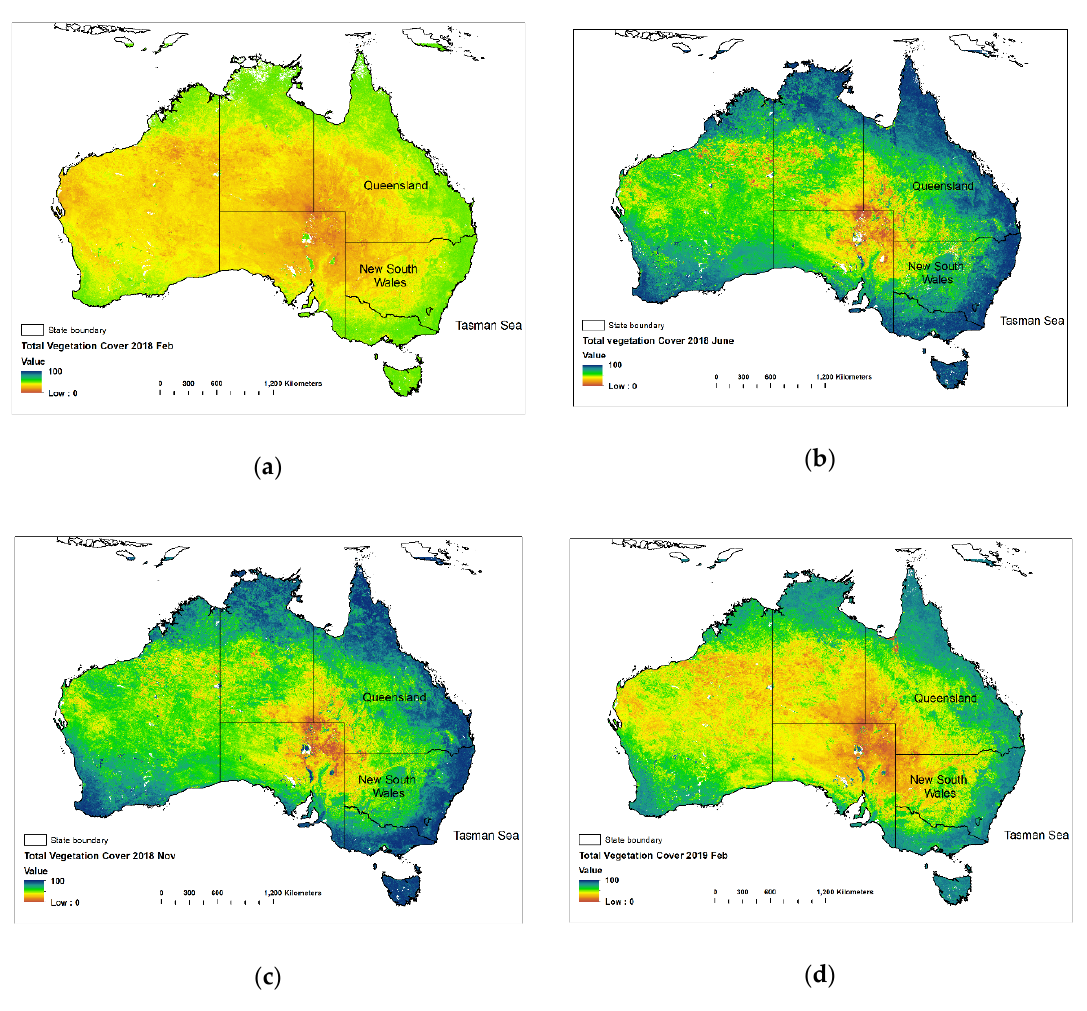
Figure 1. Total vegetation cover (%) for Australia in February 2018 ( a ), June 2018 ( b ), November 2018 ( c ) and February 2019 ( d ) (source: http: // www-data.wron.csiro.au / remotesensing / MODIS / products / public / v310 / australia / monthly / cover /